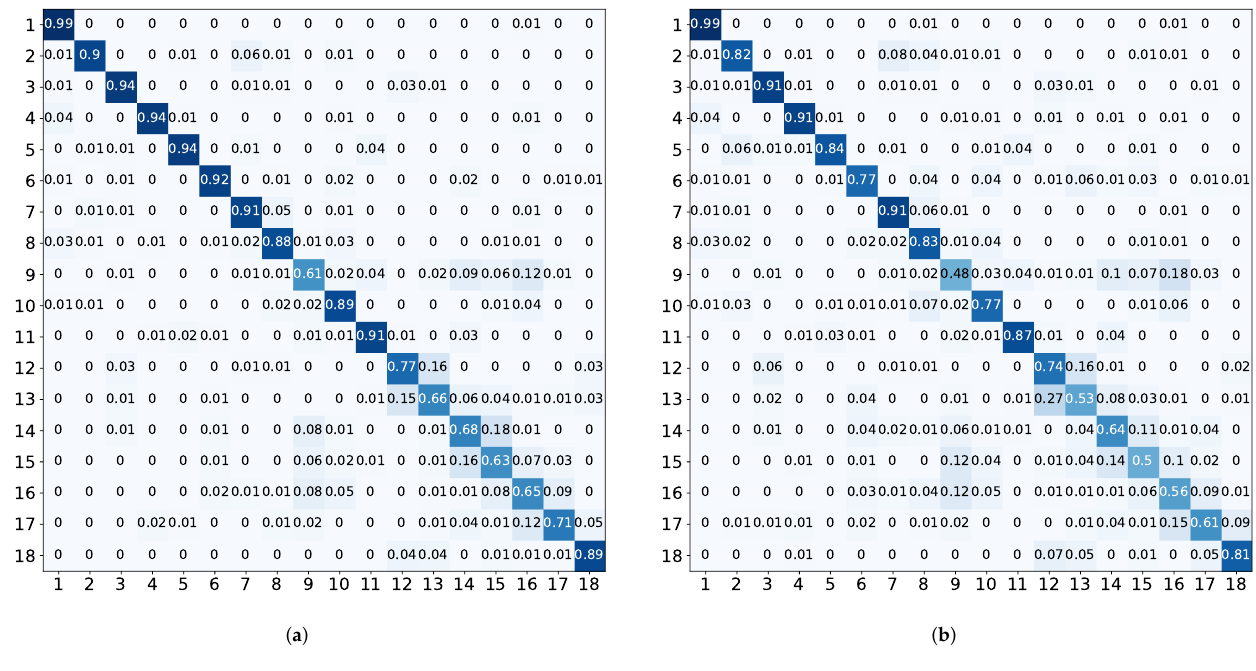
Figure 9. Confusion matrices using CNN. ( a ) 10-Fold (CNN). ( b ) LOSO